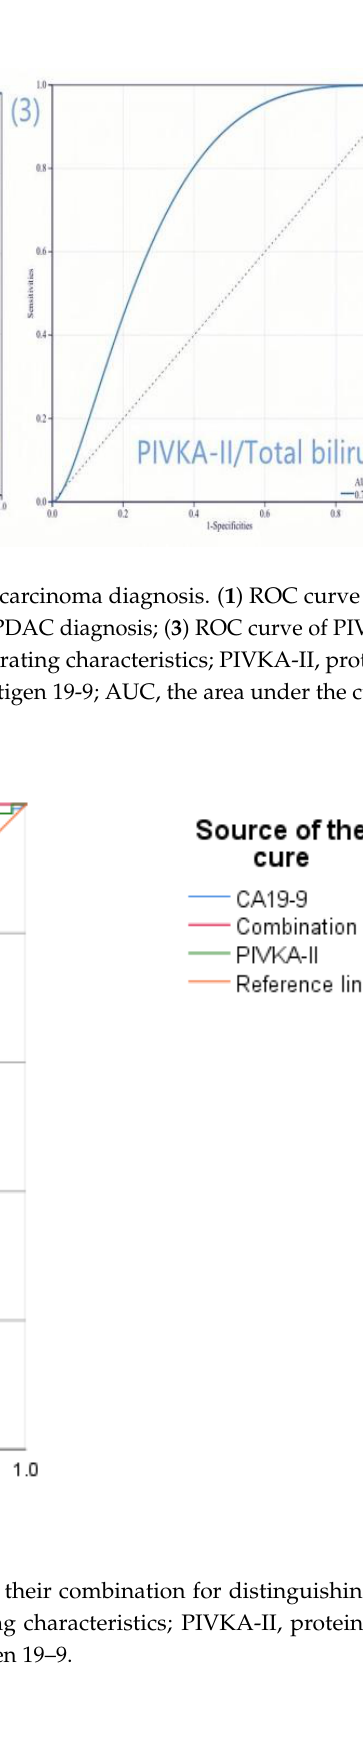
Table 3. Sensitivity, specificity, PPV, and NPV of different biomarkers in discriminating PDAC from pancreatic benign lesions. Variables